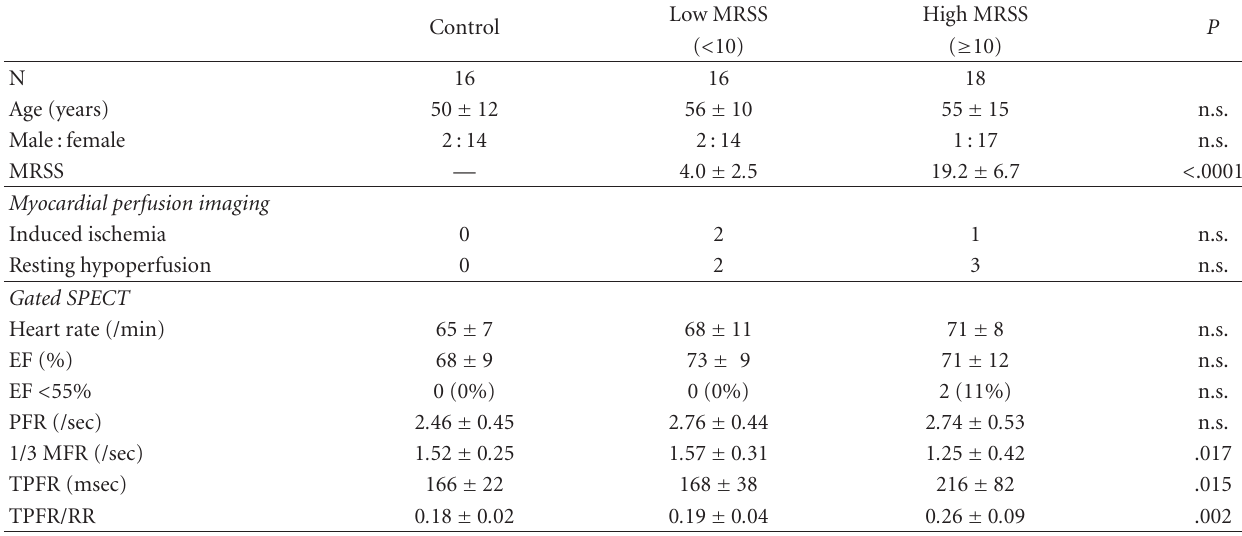
Table 2: Comparison of low and high skin thickness score in patients and control subjects.